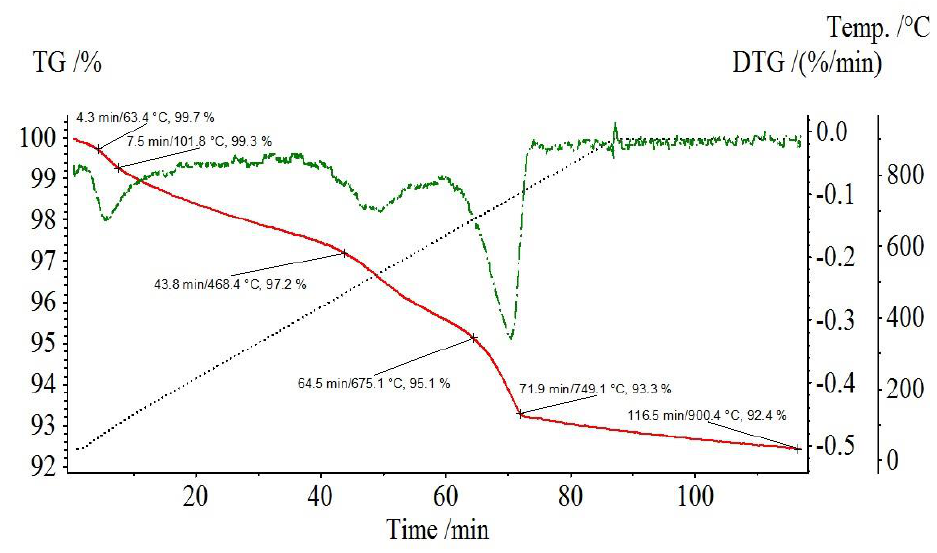
Figure 5. TG (red) and DTG (green) curves of the tuff with marked significant points.